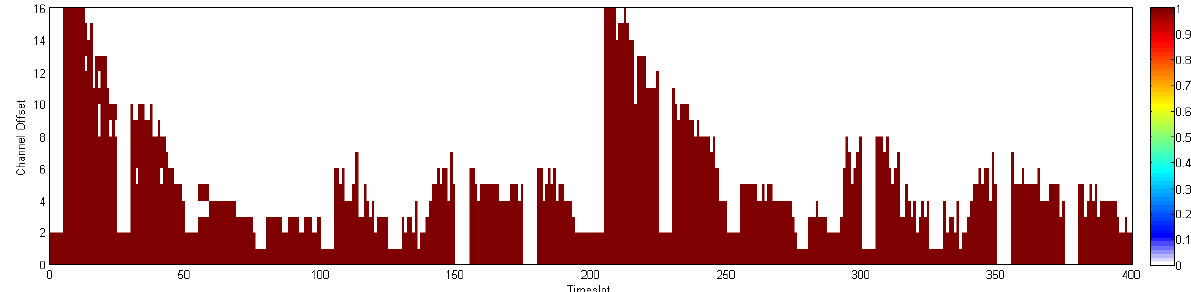
Figure A9. Communication schedule of WirelessHART network with 19 nodes per one-hop neighborhood.